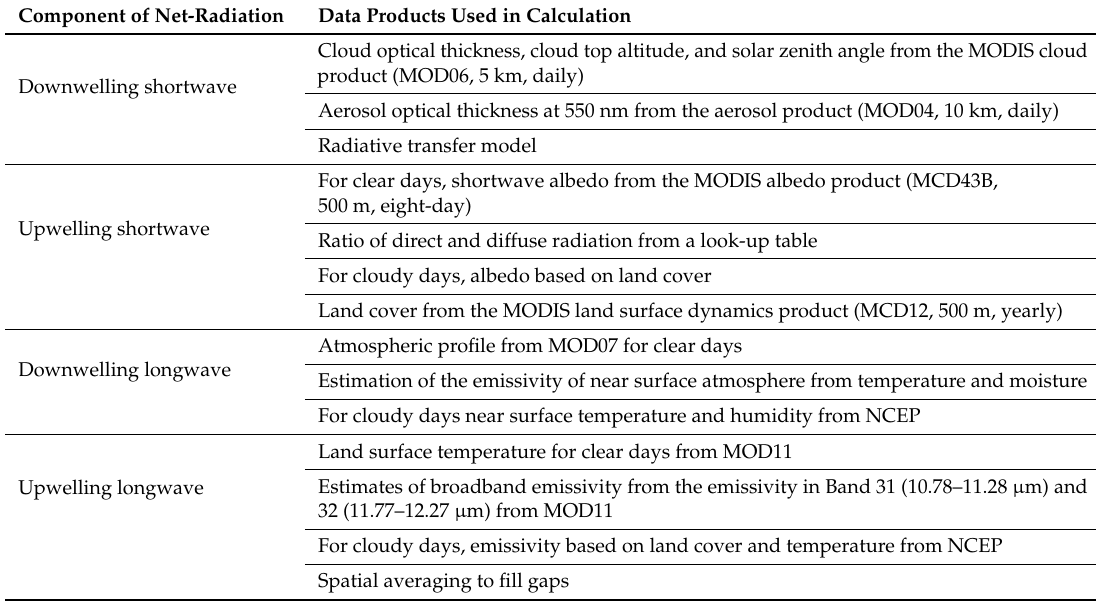
Table 1. Different data products used in calculating the four components of net-radiation in clear and cloudy